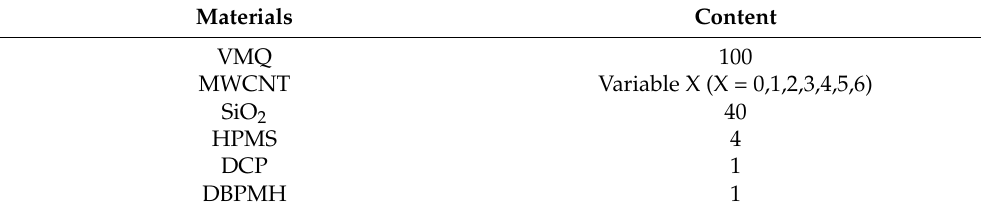
Figure 1. ( a ) Preparation process of the conductive silicone rubber composites, ① – ④ indicates the adding sequence. ( b ) Image of the specimen under original, tensile, bending and torsion conditions. ( c ) Device and test used to determine the strain sensing behavior of the composites. Table 1. The formula of the MWCNT/VMQ composites (wt%).